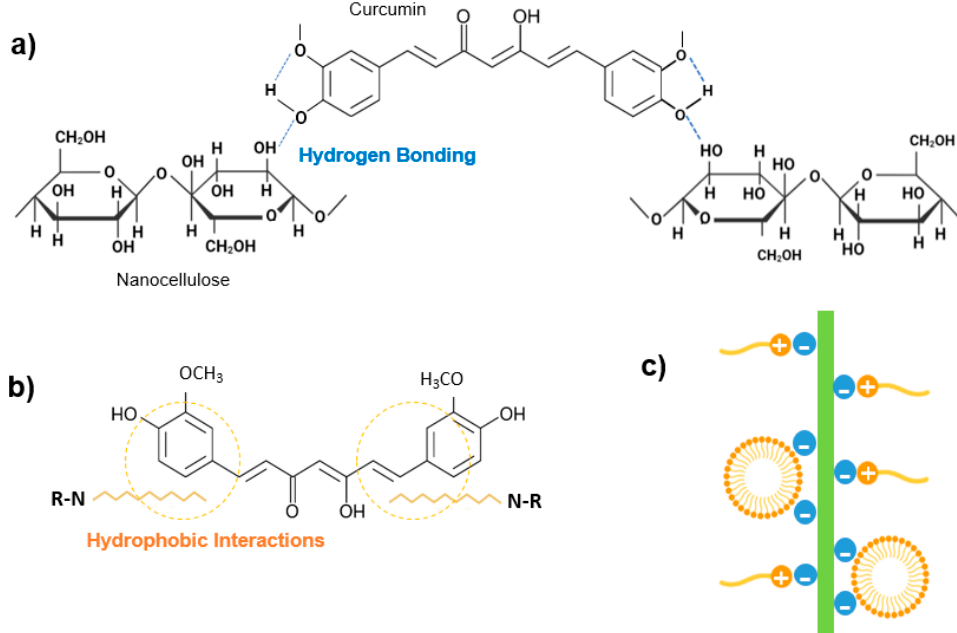
Figure 5. ( a ) Representation of hydrogen bonding between curcumin and nanocellulose structures; ( b ) Representation of hydrophobic interactions between curcumin and hydrophobic modified nanocellulose; ( c ) Schematic illustration of CTAB and nanocellulose interactions.